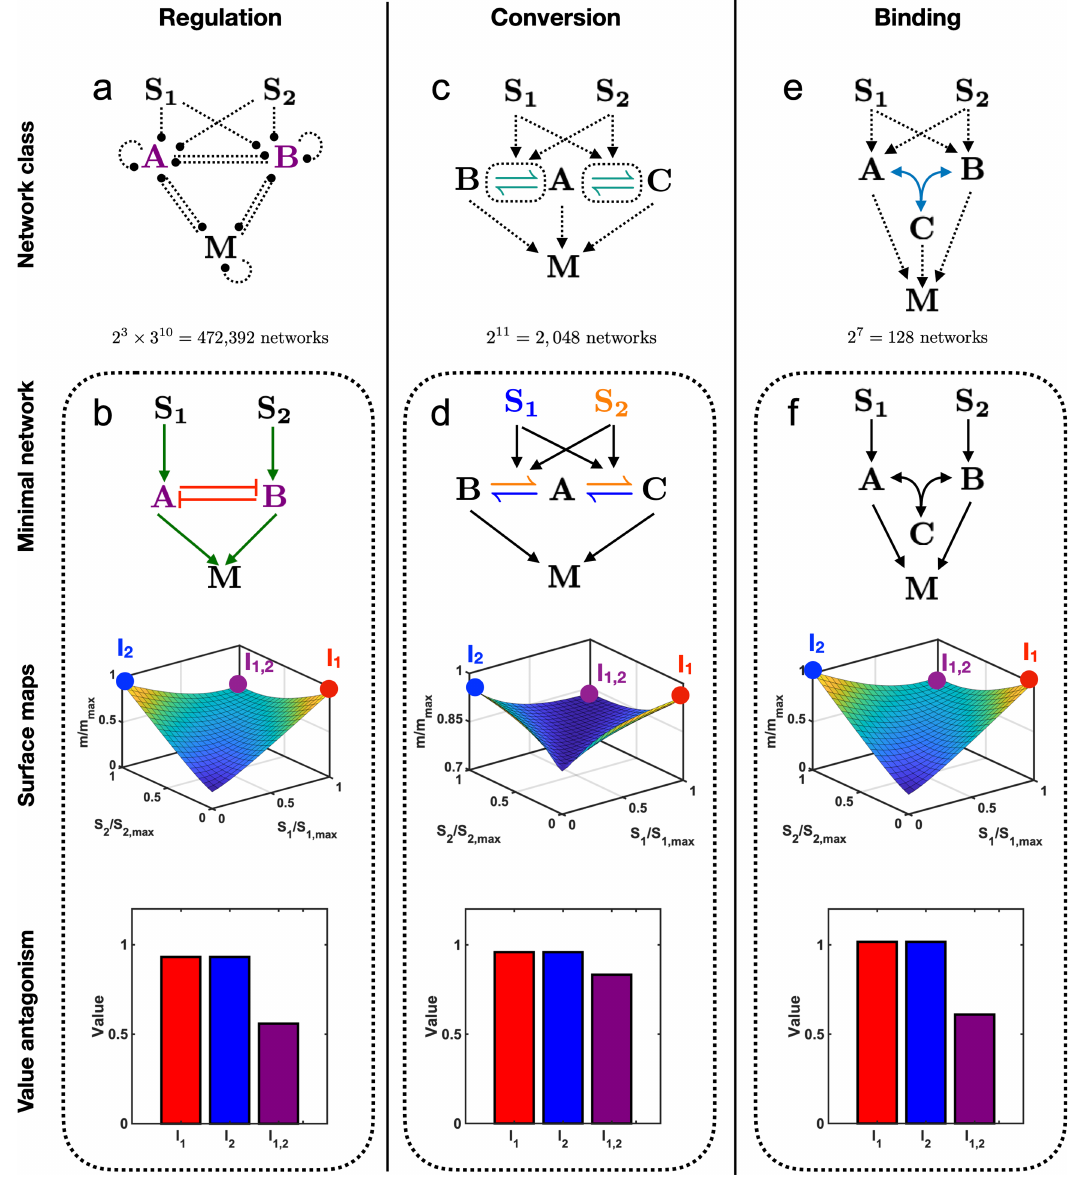
Fig. 5 Value antagonism. Value antagonism occurs if the value of the output with either input present alone is larger than the value when both inputs are present. The minimal a regulation network class contains b a minimal network that achieves value antagonism by mutual inhibition. The minimal c conversion network class contains d a minimal network that achieves value antagonism by competing fl uxes. The minimal e binding network class contains f a minimal network that achieves value antagonism by sequestration. In all cases, the output is lower with both inputs present than with either input alone (surface maps) and thereby shows value antagonism (bar graphs). The values at I 1 , I 2 , and I 1,2 are calculated at S i ¼ S i ; max